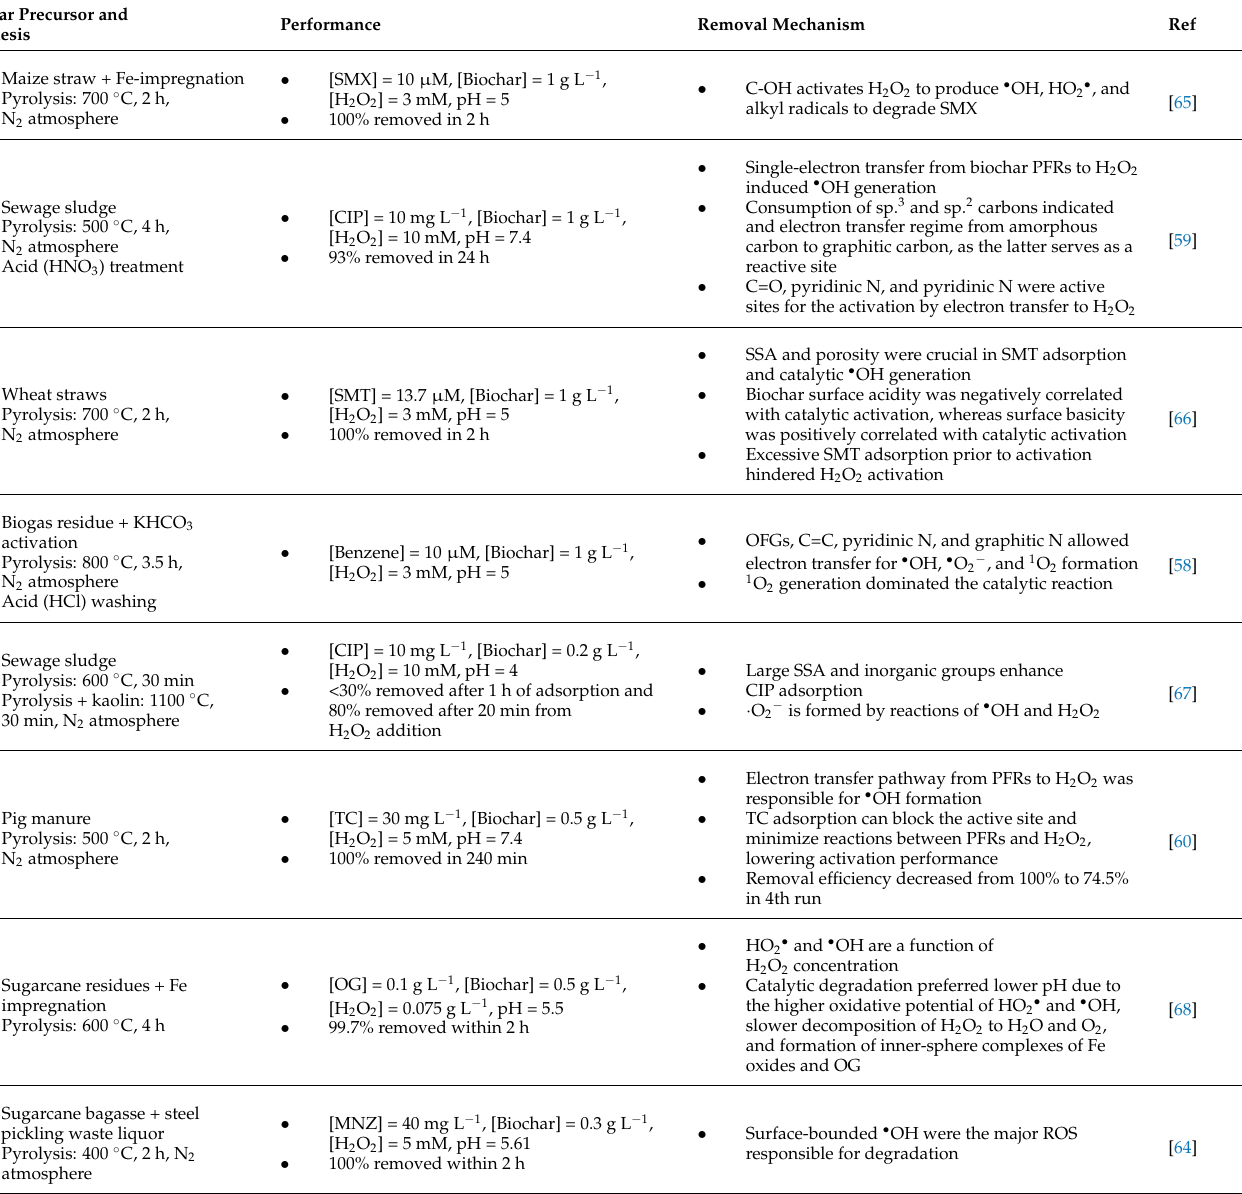
Table 2. An overview of biochar preparation and performance in H 2 O 2 activation for organic pollutants